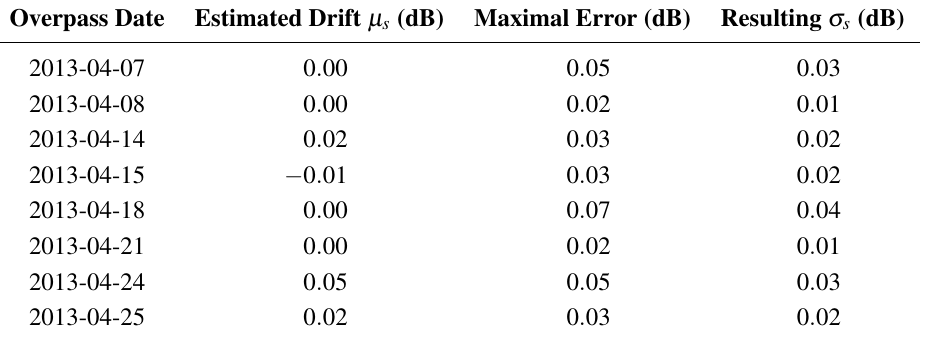
Table 4. Daily transponder RCS drift, estimated maximal error bounds on the estimated drift, and resulting standard uncertainties according to Equation